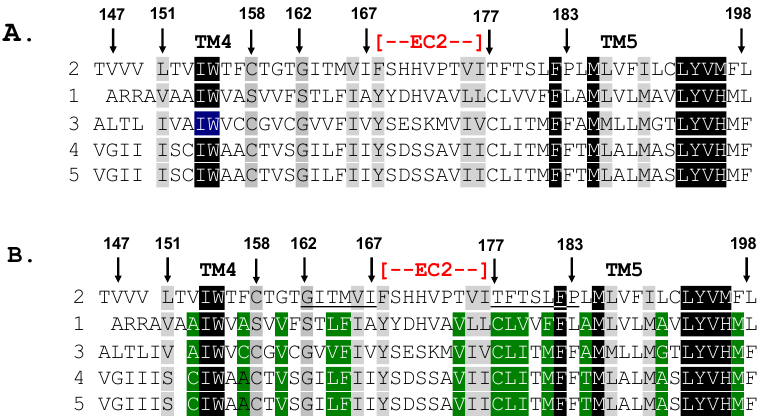
Figure 3. Alignment of Amino Acid Sequences of TM4/EC2/TM5 Domains of Human MCRs: Identity/Similarity Analysis. ( A ) The amino acid sequences of the TM4/EC2/TM5 domains for hMC2R (AA067714.1), hMC1R (Q01726.2), hMC3R (AKI72215.1), hMC4R (NP_005903.2), and hMC5R